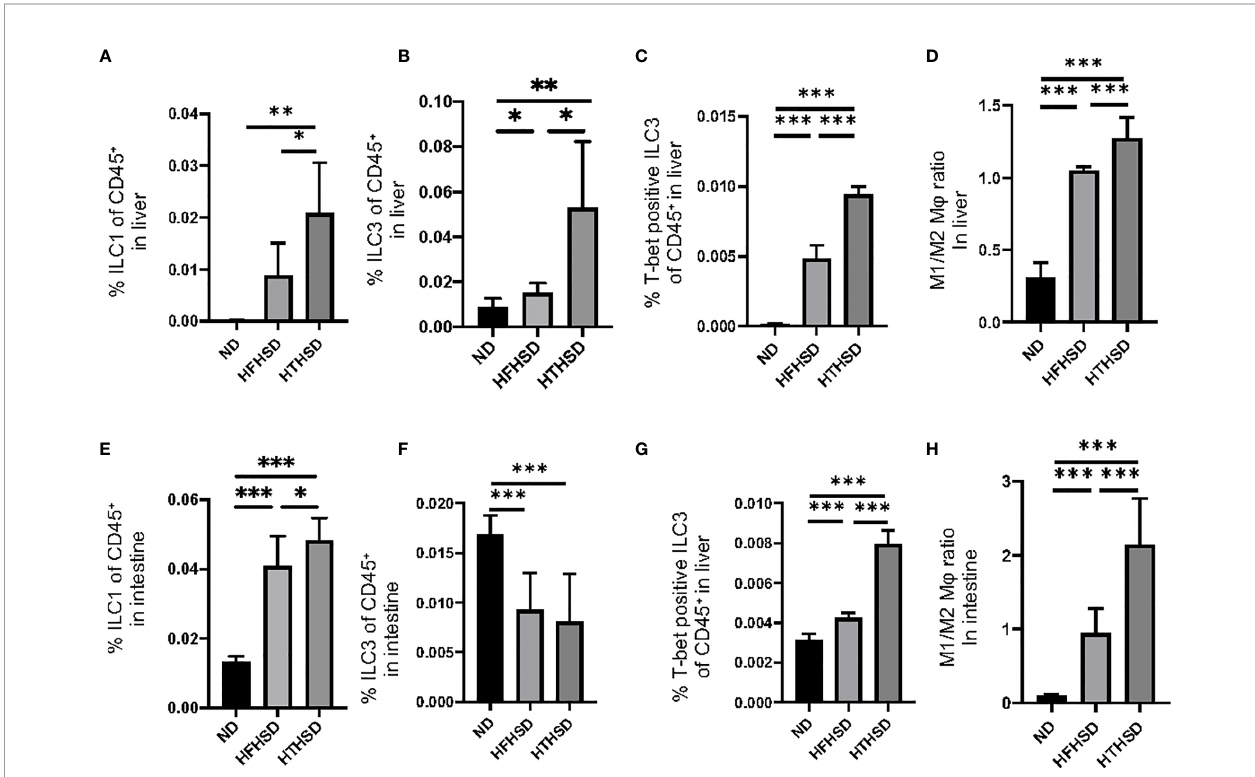
FIGURE 3 | ILC1s, T-bet-positive ILC3s, and M1/M2 macrophages ratio in liver and small intestine in mice fed with HTHSD signi fi cantly increased compared. On the other hand, ILC3s in liver in mice fed with HTHSD increased, whereas those in small intestine decreased. (A) Ratio of ILC1s to CD45-positive cells in the liver (n=6). (B) Ratio of ILC3s to CD45-positive cells in the liver (n=6). (C) Ratio of T-bet-positive ILC3s to CD45-positive cells in the liver (n=6). (D) Ratio of M1 macrophages to M2 macrophages in the liver (n=6). (E) Ratio of ILC1s to CD45-positive cells in the small intestine (n=6). (F) Ratio of ILC3s to CD45-positive cells in the small intestine (n=6). (G) Ratio of T-bet-positive ILC3s to CD45-positive cells in the liver (n=6). (H) Ratio of M1 macrophages to M2 macrophages in the liver (n=6). Data are represented as mean±SD; *p < 0.05, **p < 0.01, ***p < 0.001 using one-way ANOVA and an unpaired, two-tailed Student ’ s t